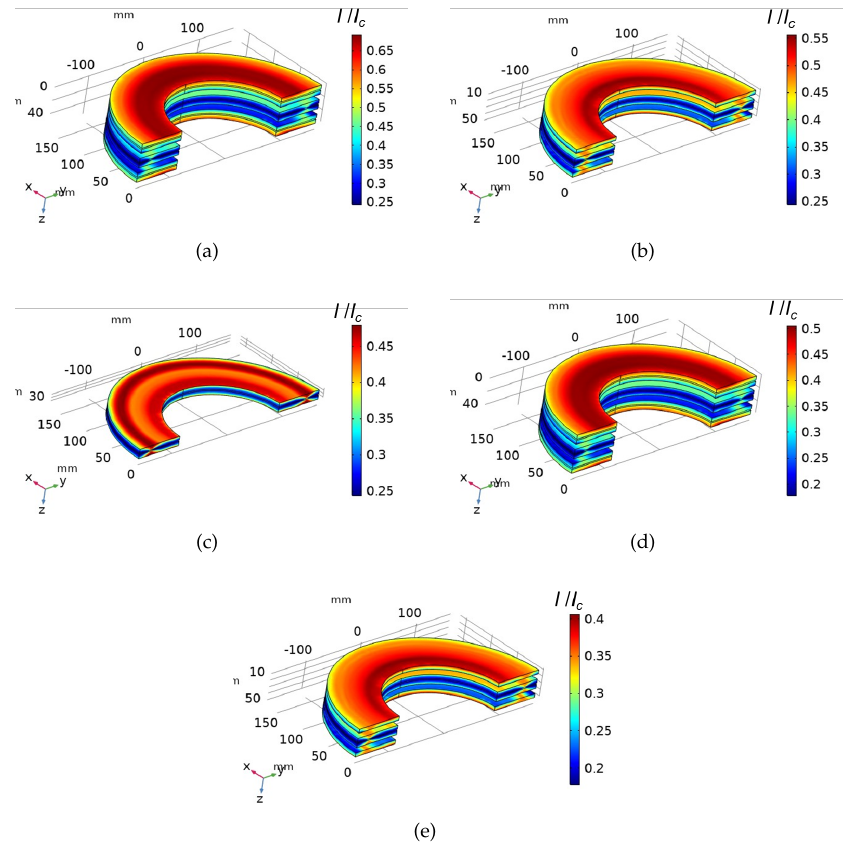
Figure 9. Load factor distribution on the arc edge of the single pole at 30 K. Tape B: ( a ) six single pancakes; ( b ) four central single pancakes; ( c ) two central single pancakes. Tape A: ( d ) six single pancakes; ( e ) four central single